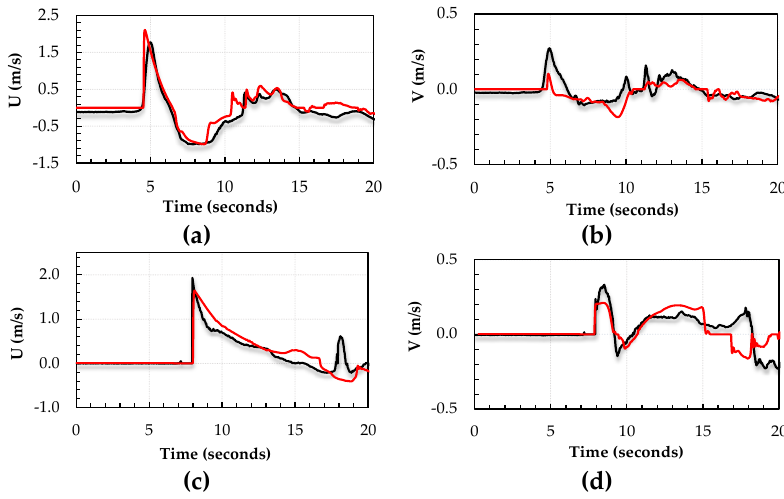
Figure 4. Comparison of results: ( a ) horizontal velocity in x-direction, U, recorded at X = 13.0 m, Y = 0.0 m and Z = 0.75 m at Gage 2; ( b ) horizontal velocity in y-direction, V, recorded at X = 13.0 m, Y = 0.0 m and Z = 0.75 m at Gage 2; ( c) horizontal velocity in x-direction, U, recorded at X = 21.0 m, Y = −5.0 m and Z = 0.77 m at Gage 9; ( d ) horizontal velocity in y-direction, V, recorded at X = 21.0 m, Y = −5.0 m and Z = 0.77 m at Gage 9. Black line represents benchmark data, red line represents numerical results.